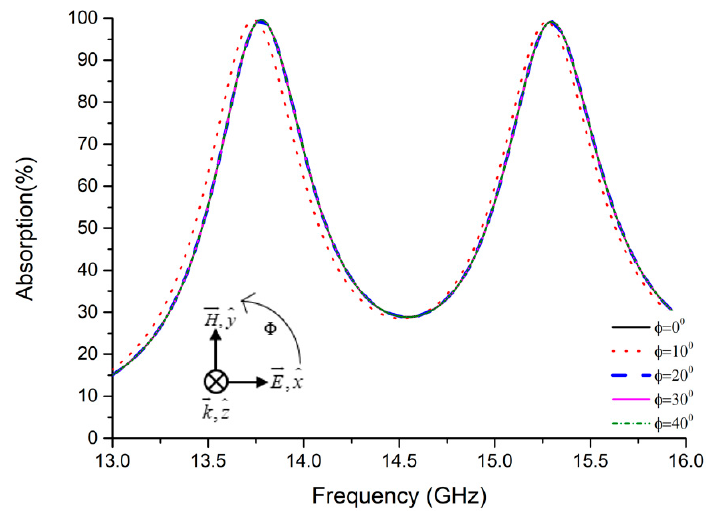
Figure 6. Absorption of quasi-TEM polarization independence of the proposed absorber.